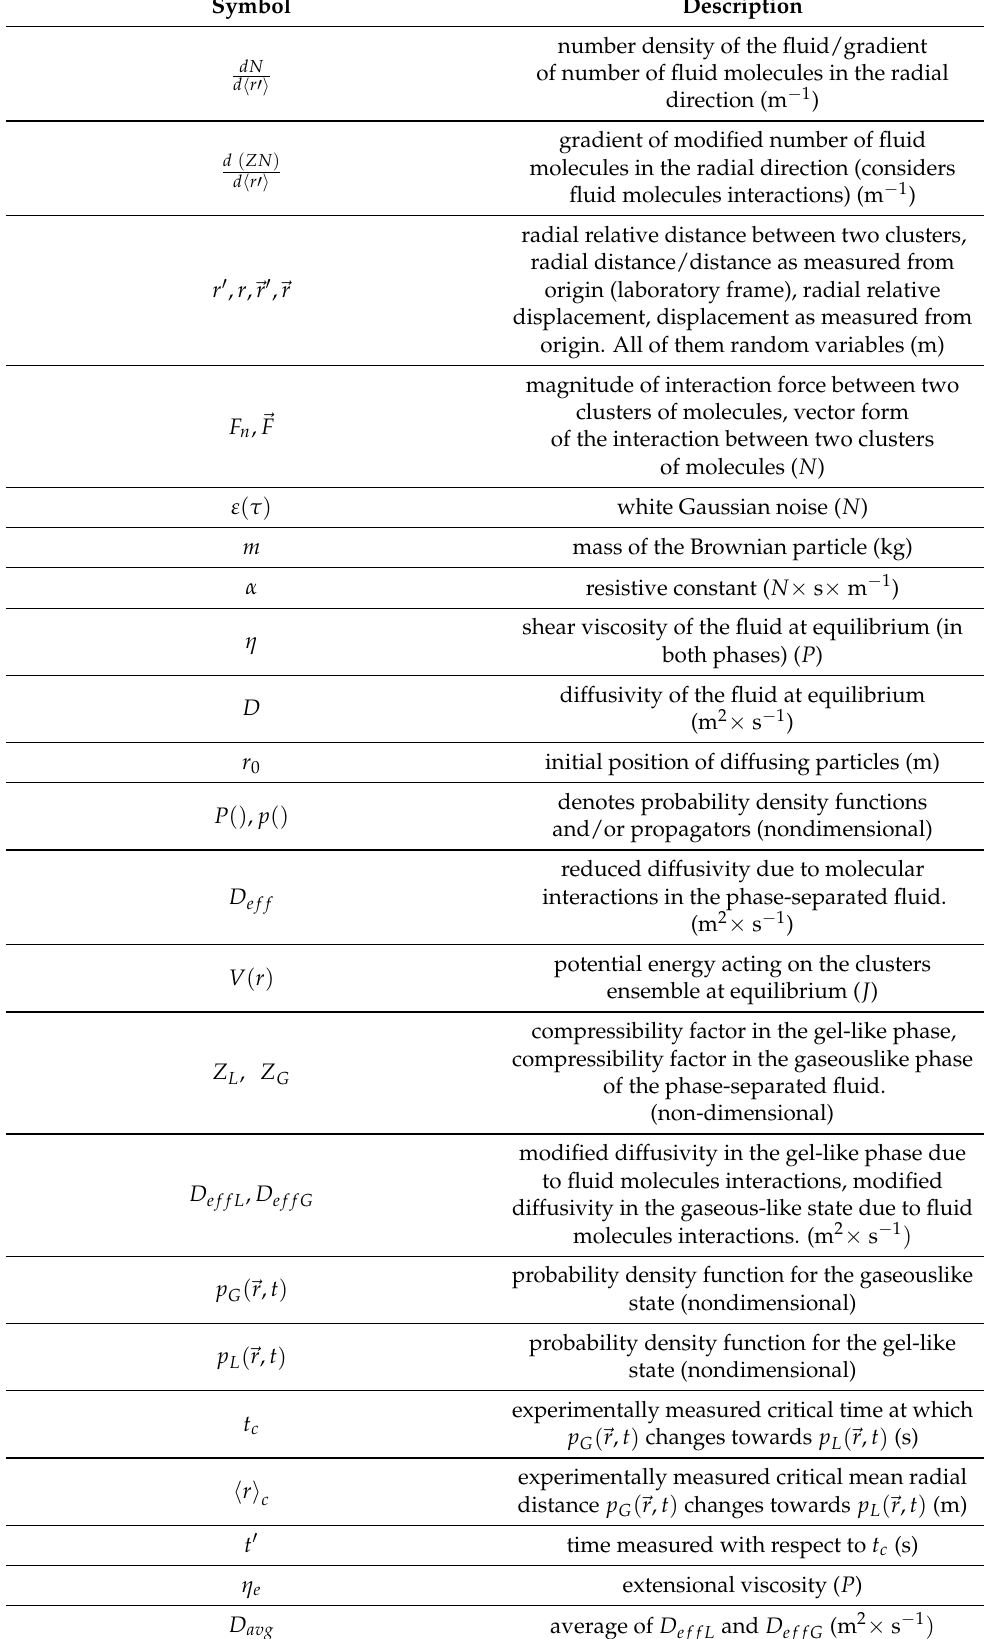
Table A2. Cont. Symbol